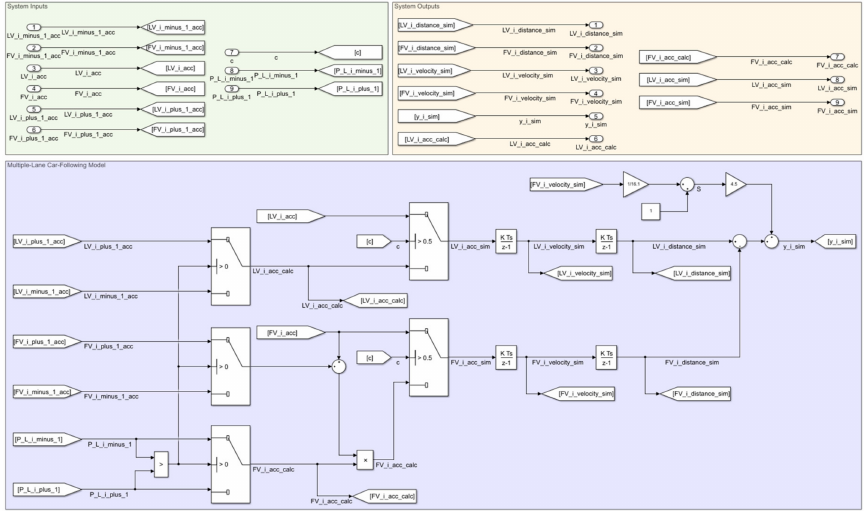
Figure 8. Proposed model-implementation using Simulink (MATLAB R2020a).